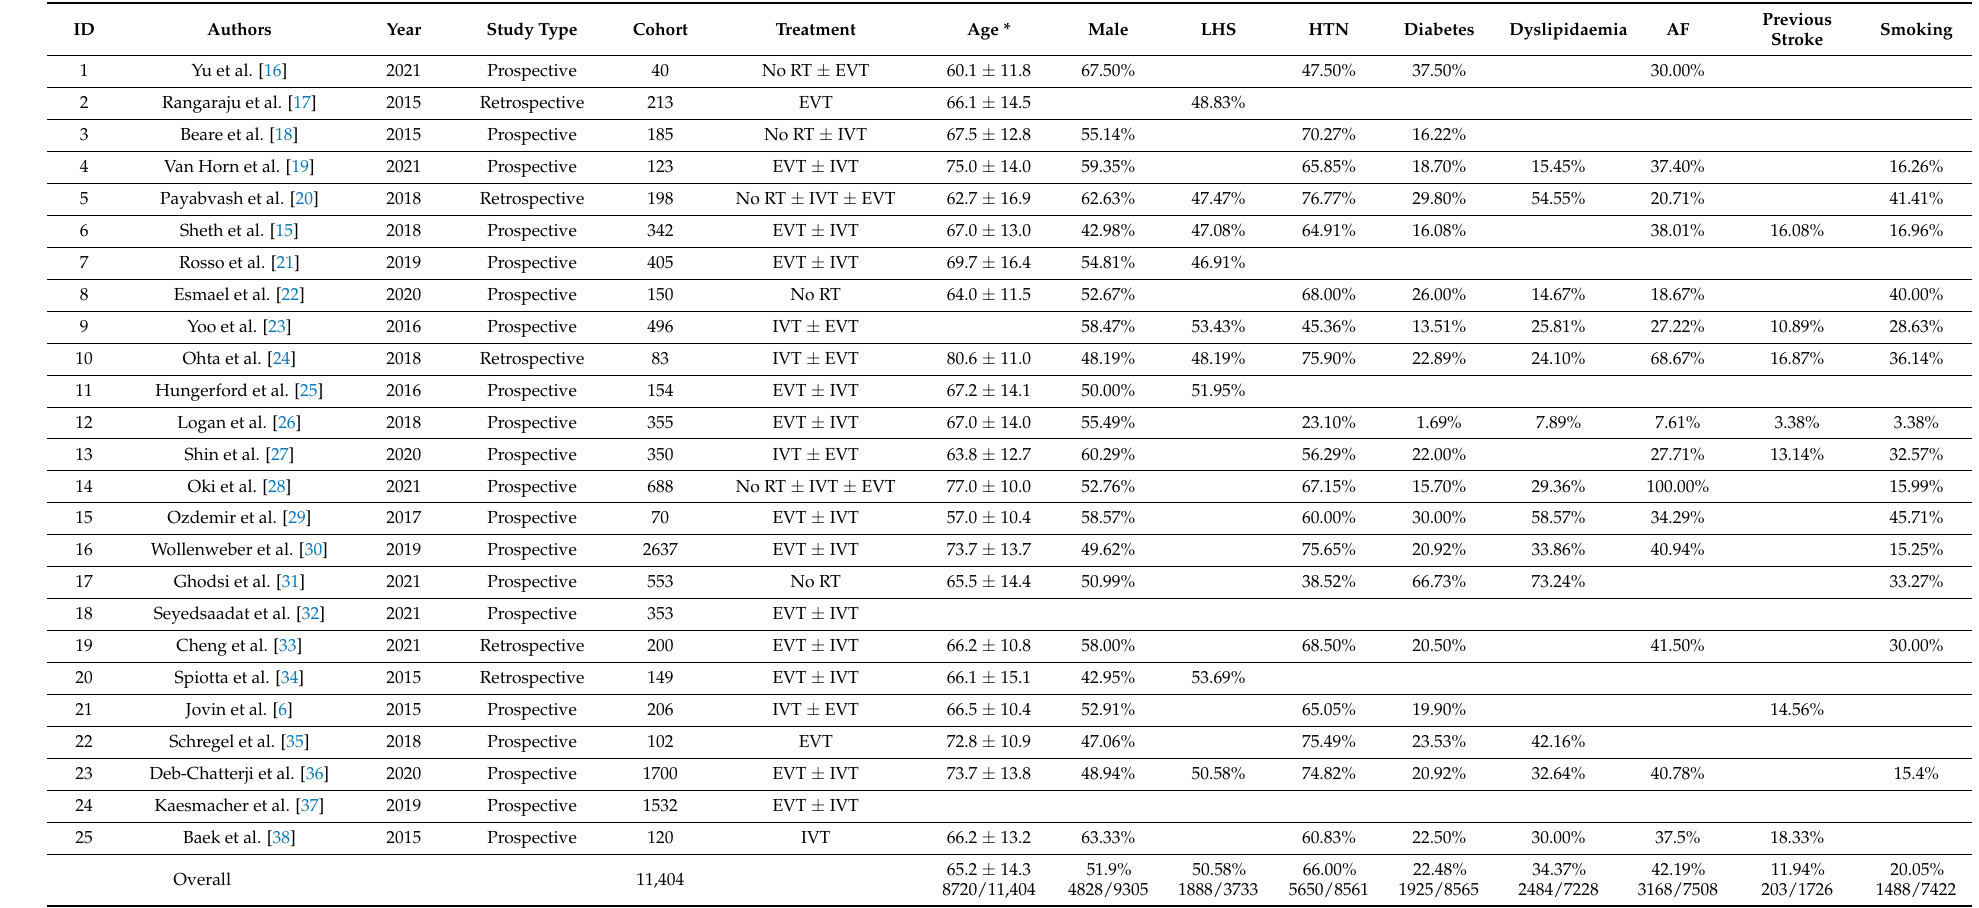
Table 1. Clinical characteristics and clinical outcomes of studies included in the